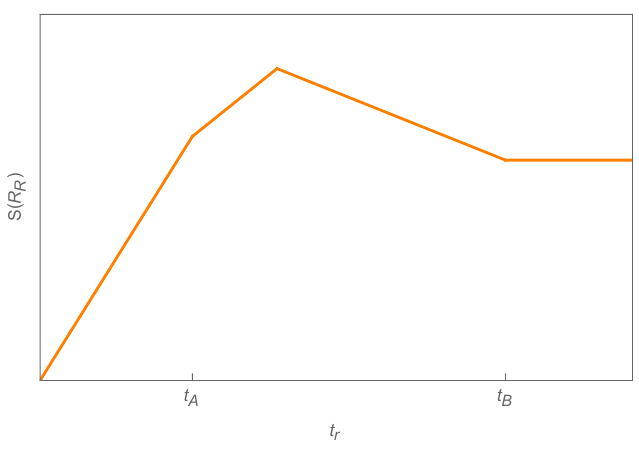
Figure 6 . Behavior of the entropy S ( R R ) in the scenario where a pulse is applied during the time t A ≤ t r ≤ t B before the saturation time is reached. The entropy is therefore always lower than the de Sitter